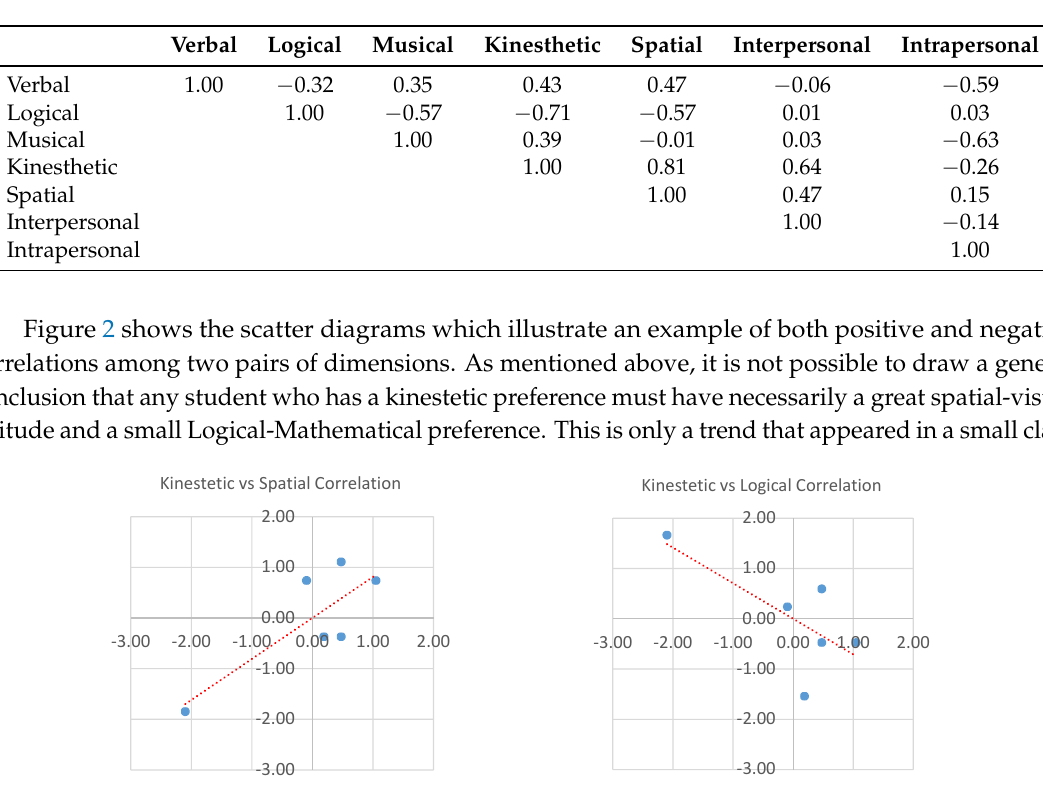
Table 1. Correlation table for the group of participating students ( n = 6).